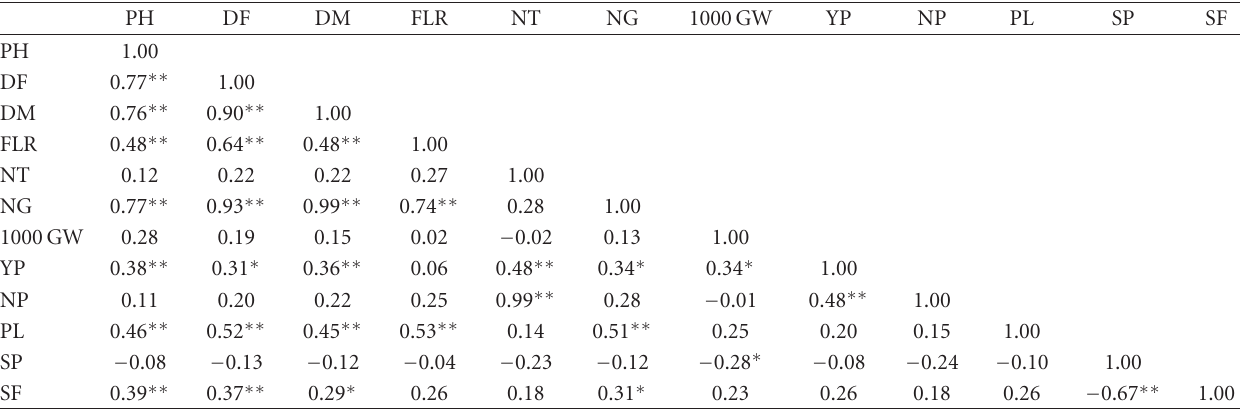
Table 6: Pearson’s correlation coe ffi cient among 12 quantitative traits of upland rice.